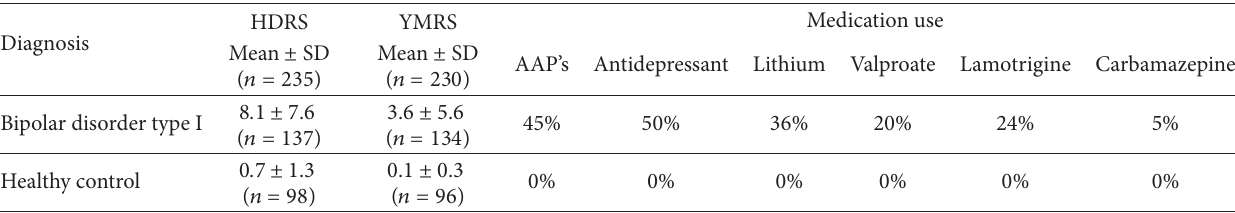
Table 2: Here we provide clinical information on study